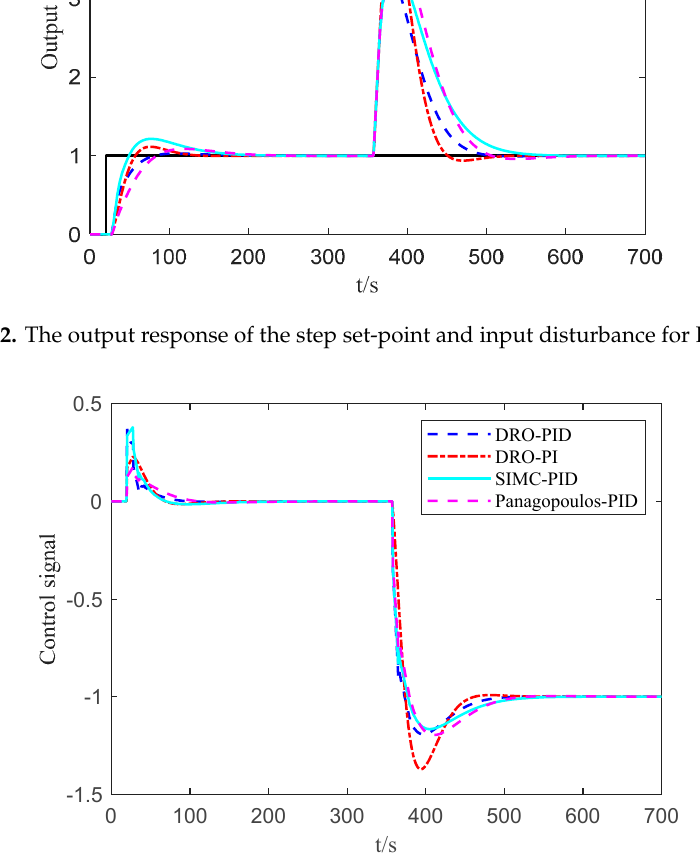
Figure 13. The control signal of the step set-point and input disturbance for Example 3. Table 8. The indices of Example 3 with different controllers.